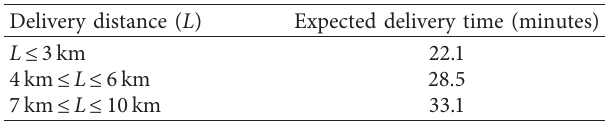
Table 2: Consumers’ expected delivery time at different